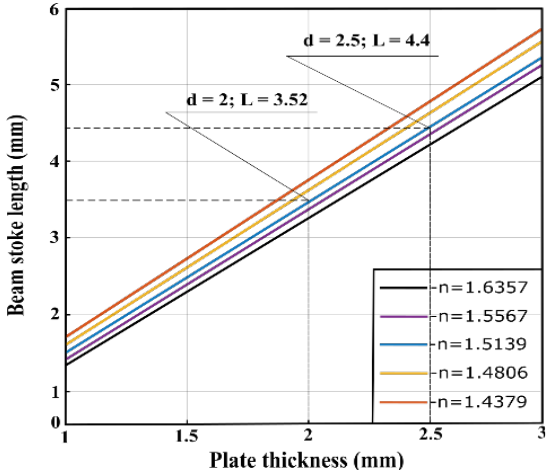
Figure 3. The dependence of the beam stoke length on the thickness of the glass for different materials.